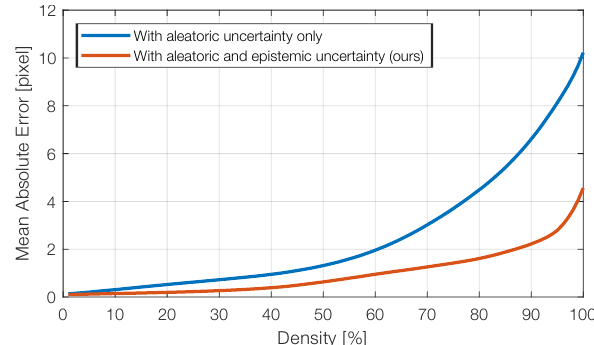
Figure 5: Relative error uncertainty relation on all images of the Middlebury dataset. A curve represents the mean absolute error as a function of the percentage of pixels sampled from a disparity map in order of increasing uncertainty. In case of an optimal uncertainty estimation, this procedure would be equal to sample pixels in the order of increasing error, resulting in a min- imal area under the